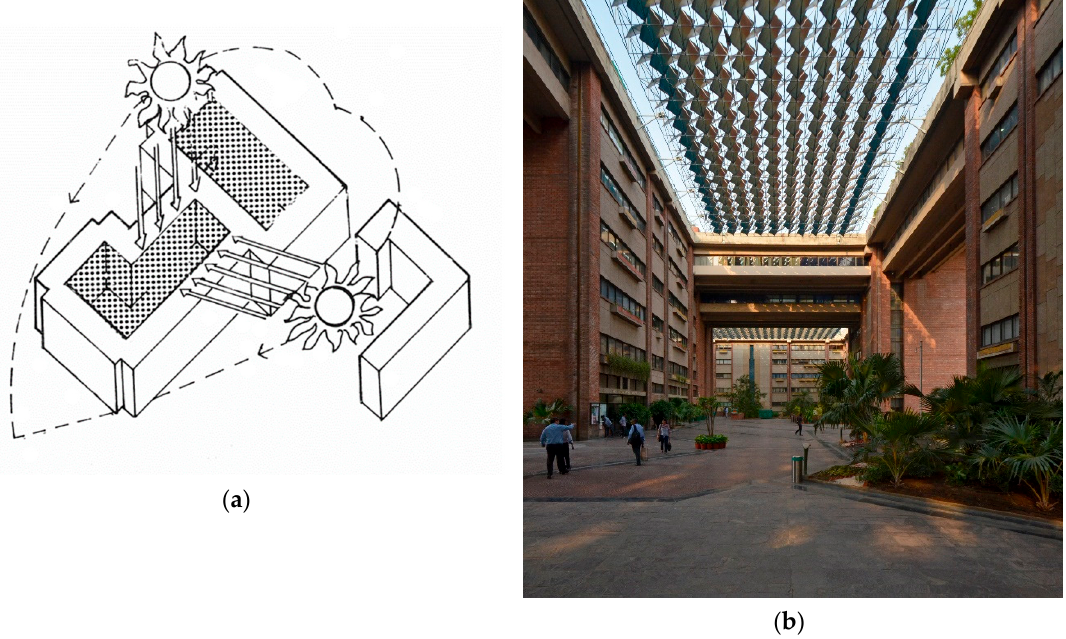
Figure 16. ( a ) Isometric drawing depicting variable shading of internal courtyards by sun-screen pergolas during summers and winters [29] (p. 131); ( b ) photograph of an internal courtyard of the India Habitat Centre (IHC) building with an overhead sun-screen pergola (Photo: Author).